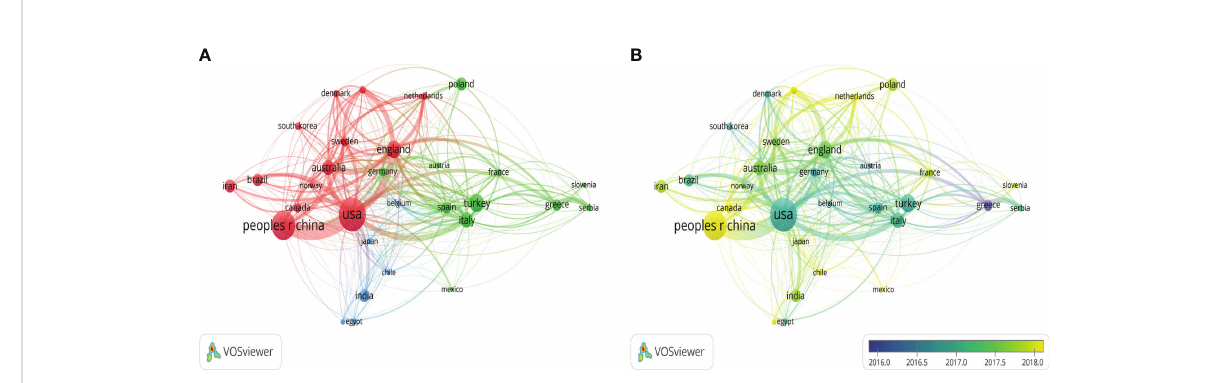
FIGURE 4 Visualization map of countries and districts. (A) Network diagram of the top 30 countries/districts. (B) Dynamics and trends of the top 30